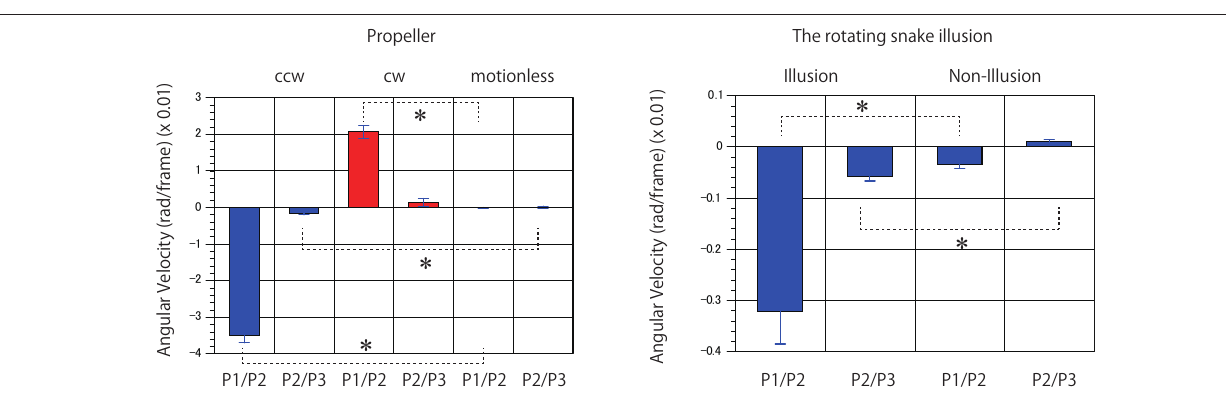
between the mean values were analyzed using unpaired t -tests (one-tailed Welch’s t -test or Student’s t